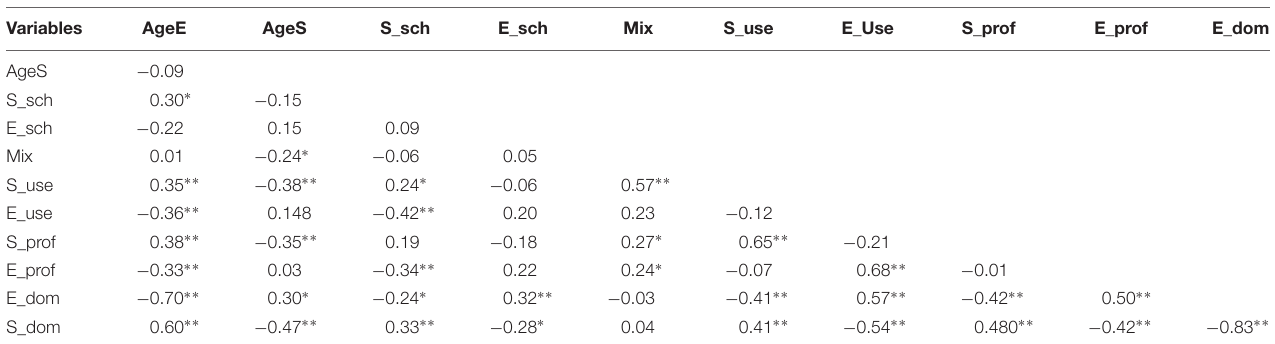
TABLE 2 | Summary of intercorrelations for scores on language